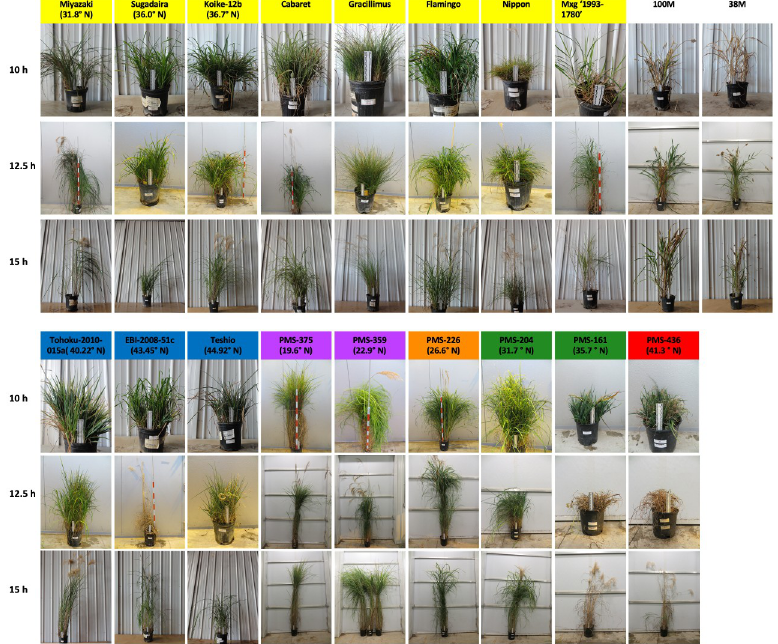
Fig 6. Photographs of plants at the end of the growth chamber experiments on the effect of day-length on Miscanthus . Plants were tested under each of three day lengths: 10, 12.5, and 15 h. Colored background behind Miscanthus genotype names represent the M . sinensis genetic groups identified by Clark et al . [23, 24], which included Korea/North China (red), Yangtze-Qinling (green), Northern Japan (blue), Southern Japan (yellow), Sichuan Basin (orange), and Southeastern China plus tropical (purple); for interspecific hybrids between M . sacchariflorus and M . sinensis (Nippon and M × g ‘1993–1780’), the dominant M . sinensis genetic group is shown. Representatives of each genetic group and a range of latitudes (in parentheses) are shown. In each photo, plant size is scaled by either a 20 cm ruler (black and white) or a 1 m stick (orange and white). Note that accessions originating from high latitudes typically remained short and had few or no flowering stems when grown under short days but were taller and flowered when grown under long